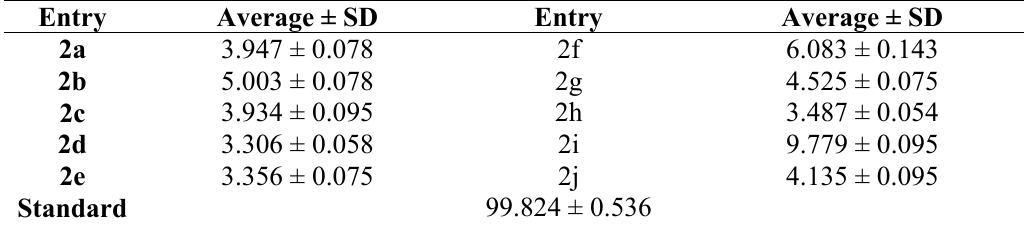
Table 6. Haemolytic activity of synthetic compounds 2a – j